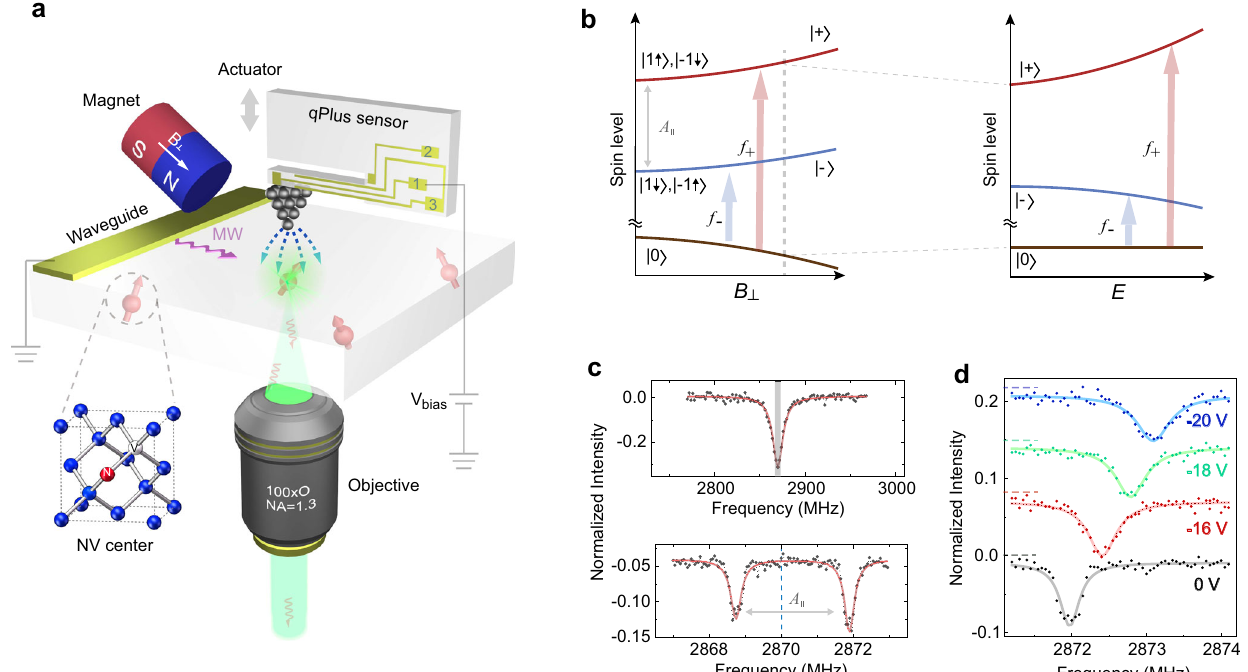
Fig. 1 Sensing the external fi eld from AFM tip using single shallow NV. a Schematic graph of the home-built AFM system combined with NV technology. A metal tip was guided close to a speci fi c NV using a qPlus sensor, where the electrode for bias is denoted by 1 and the electrodes for AFM signals are denoted by 2 and 3. A piezo actuator (gray arrow) is used for exciting the oscillations of qPlus. Microwave (MW) pulses feed through the on-chip waveguide. The transverse magnetic fi eld B ⊥ is dentoed by a white arrow, with the magnitude of 9.6 G. b Left: The spin levels of NV − under transverse magnetic fi eld with varying strength. Hyper fi ne interaction of associated N 15 isotope is denoted by A k . The states (| 1 ↑ 〉 , | − 1 ↓ 〉 ) and (| − 1 ↑ 〉 ,| + 1 ↓ 〉 ) (denoted by z -projection of the electron spin-1 and its associated nuclear spin-1/2) are equally mixed into | + 〉 and | − 〉 , respectively. Right: Energy levels of | ± 〉 states under the electric fi eld with varying strength. Arrows indicate the spin resonant transition under the microwaves ( f + and f − ). c Continuous wave-ODMR (upper panel) and pulsed-ODMR (lower panel) under zero electric fi elds. The hyper fi ne splitting cannot be resolved in continuous wave- ODMR (the gray shadow), but is clearly visible in pulsed-ODMR. The vertical dashed line denotes 2.87 GHz. d Pulsed-ODMR spectra showing the = + 20 electron-spin-resonance shift of f + under different tip biases. Curves are offset for clarity. AFM setpoint: 4 f AFM